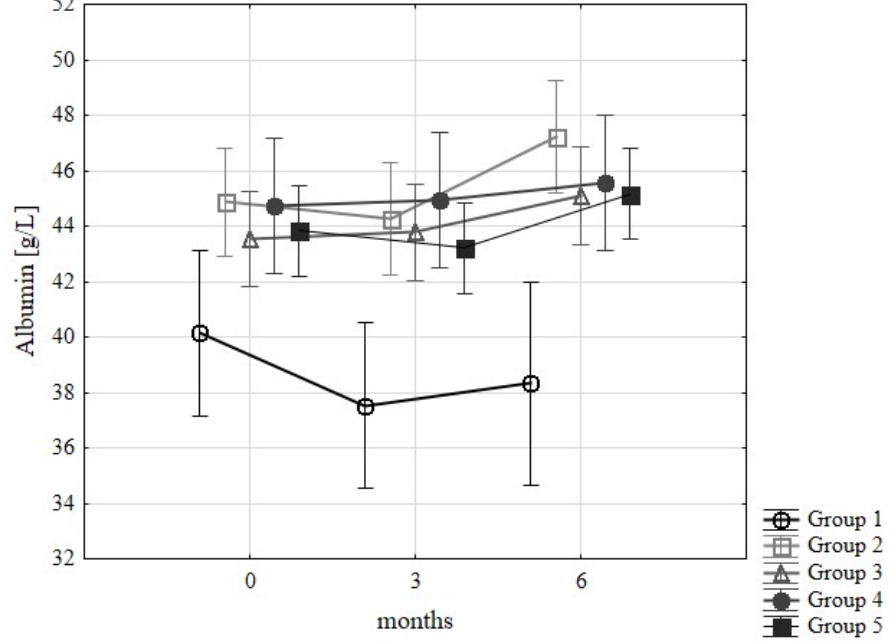
Figure 1. Changes in albumin levels (g/L) in examined groups of patients during 6 months of implementation of diet recommendations.